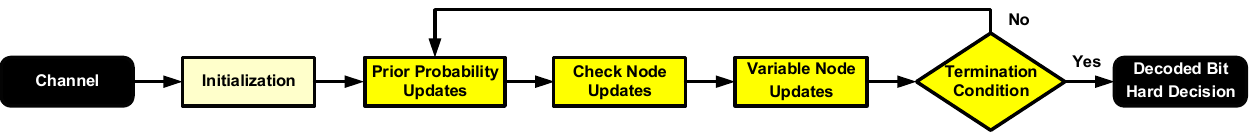
Figure 3. Flowchart of iterative LDPC decoding.